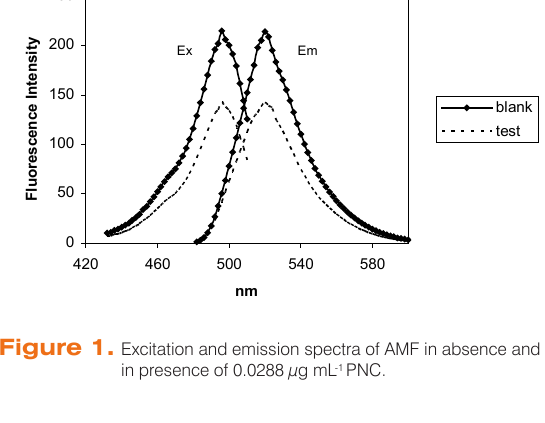
Figure 1. Excitation and emission spectra of AMF in absence and in presence of 0.0288 μg mL -1 PNC.